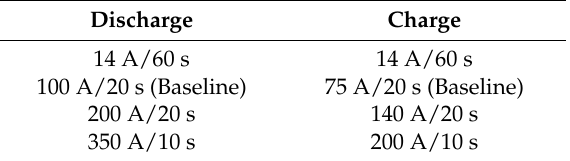
Table 1. Pulses used to identify current dependence of parameters (at 50%